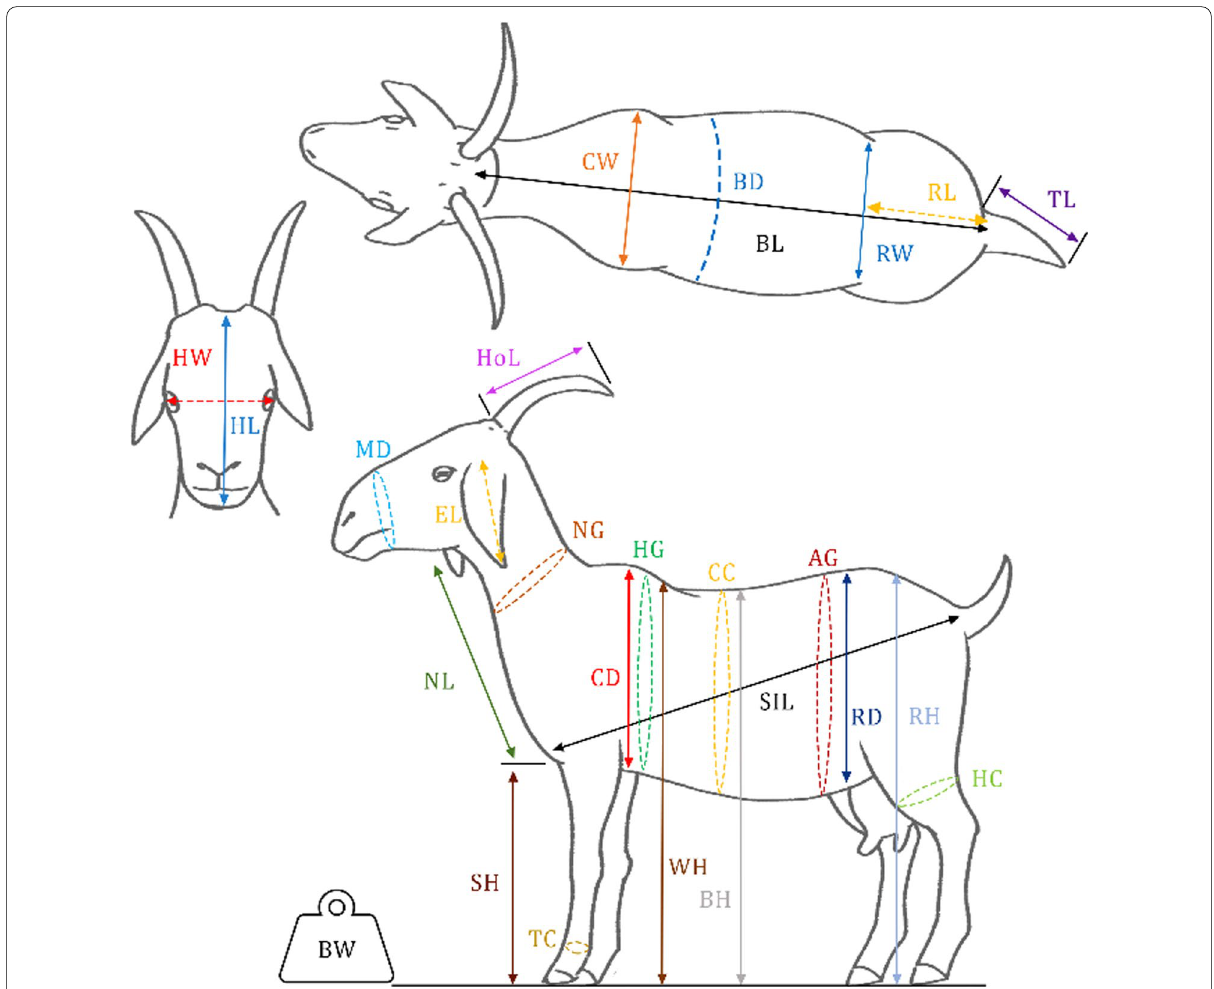
Fig. 2 Illustration of the 26 linear body measurements taken on each sampled goat. WH withers height, RH rump height, SH sternum height, BH back height, CD chest depth, RD rump depth, CW chest width, SIL scapulo-ischial length, BL body length, HL head length, HW head width, EL ear length, HoL Horn length, MD muzzle diameter, NL neck length, NG neck girth, TL tail length, HG heart girth, CC chest circumference, AG abdominal girth, BD bicoastal diameter, RW rump width, RL rump length, TC cannon bone circumference, HC hock circumference, BW body